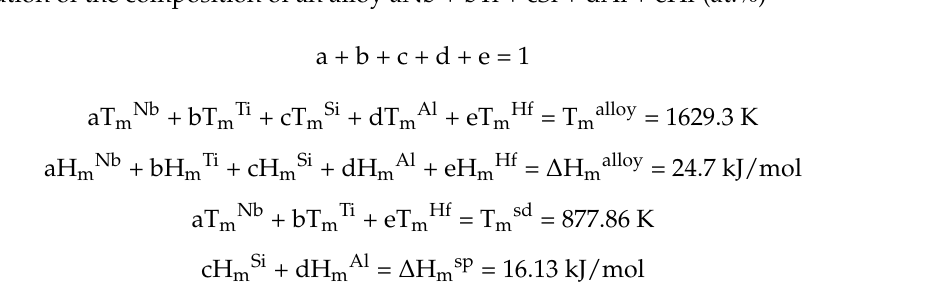
(b) γ Nb5Si3, (c) Ti5Si4, (d) TiSi, (e) TiAl; Figure S4: XRD data of the heat treated alloys at 800 ◦ C (a) MG5 and (b) MG6; Figure S5: XRD data of the heat treated alloys at 1200 ◦ C (a) MG5 and (b) MG6; Figure S6: Glancing angle XRD data at 800 ◦ C (a) MG5, (b) MG6; Figure S7: Glancing angle XRD data at 1200 ◦ C (a) MG5, (b)